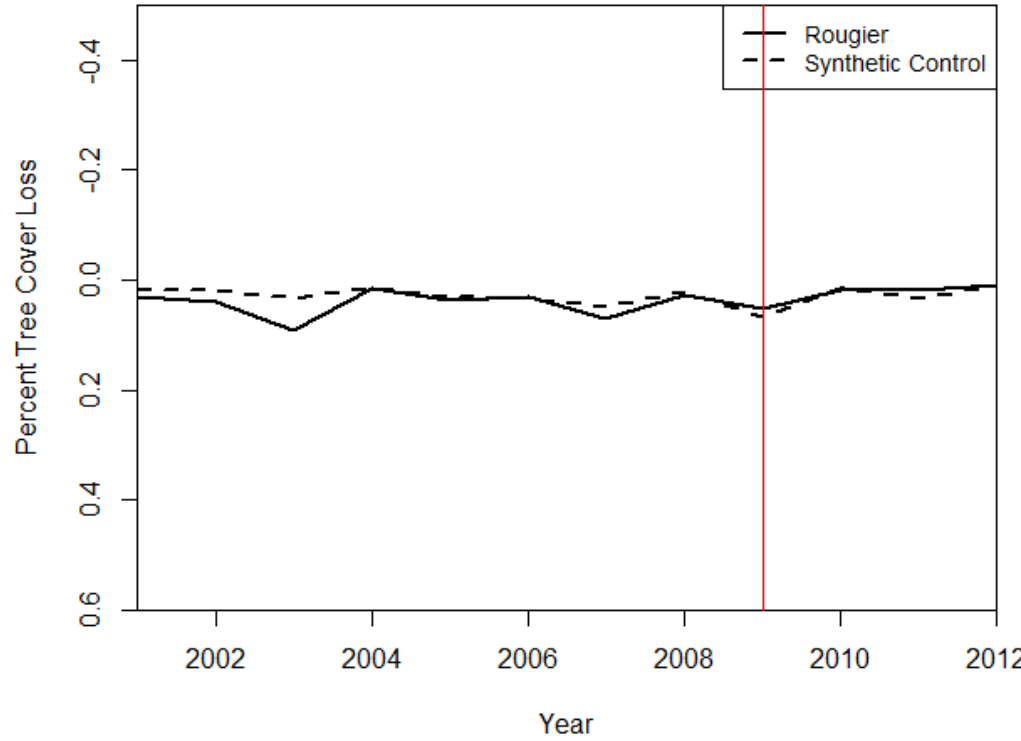
Figure 3. Comparison of tree cover loss in Rougier and its synthetic control, 2001–2012. Tree cover loss increases down the y -axis. Red line indicates the year of certification.